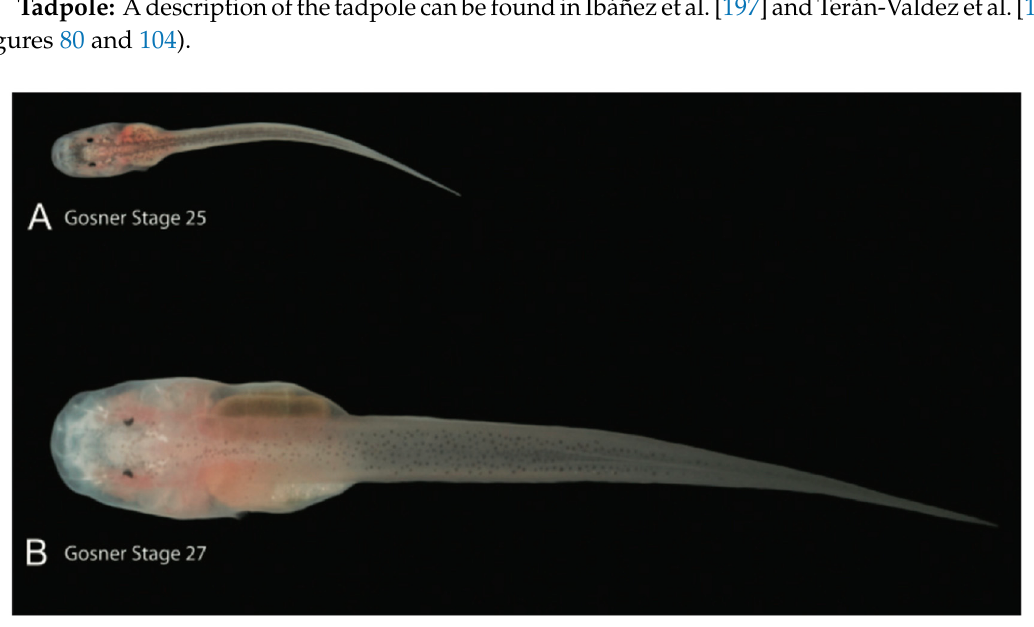
Figure 104. Hyalinobatrachium aureoguttatum , ontogenetic variation of tadpoles. ( Top ) Gosner Stage QCAZ 37752. ( B ) Gosner Stage 27, QCAZ 32072. Photos by L. A. Coloma. Figure modified 25, QCAZ 37752. ( Bottom ) Gosner Stage 27, QCAZ 32072. Photos by L. A. Coloma. Figure modified from Terán-Valdez et al. [167].